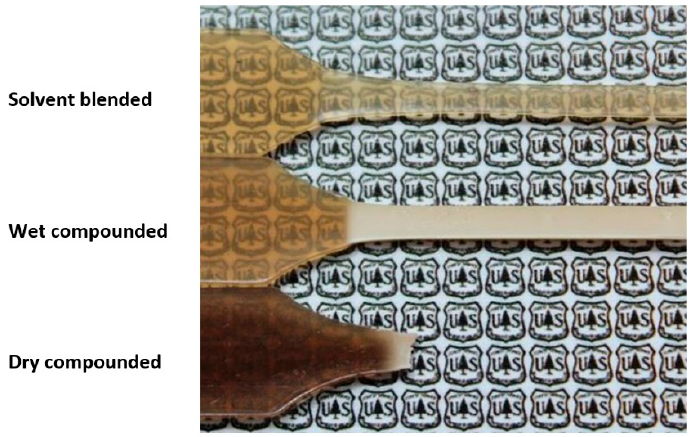
Figure 8. Injection molded PA6 specimens containing 5% CNCs after tensile testing [8].